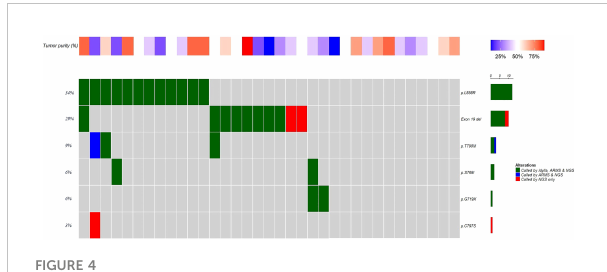
FIGURE 4 Analysis results of 35 clinical samples with Idylla, ARMS-PCR and